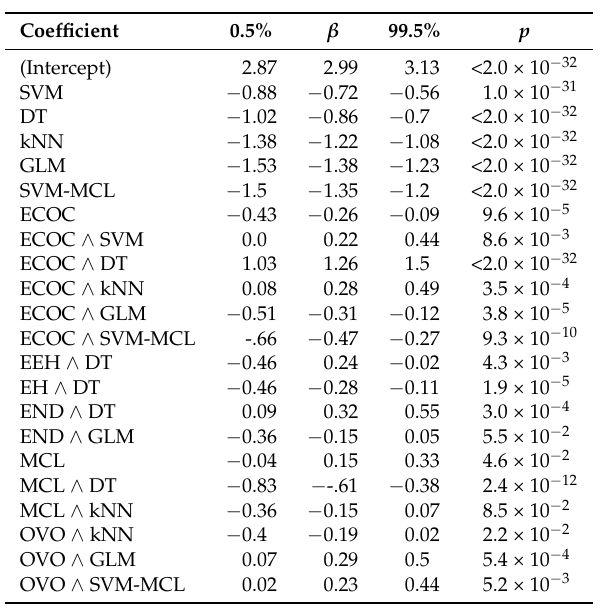
Table 5. Estimated logistic regression coefficients with p < 0.1 for the multi-class problem.